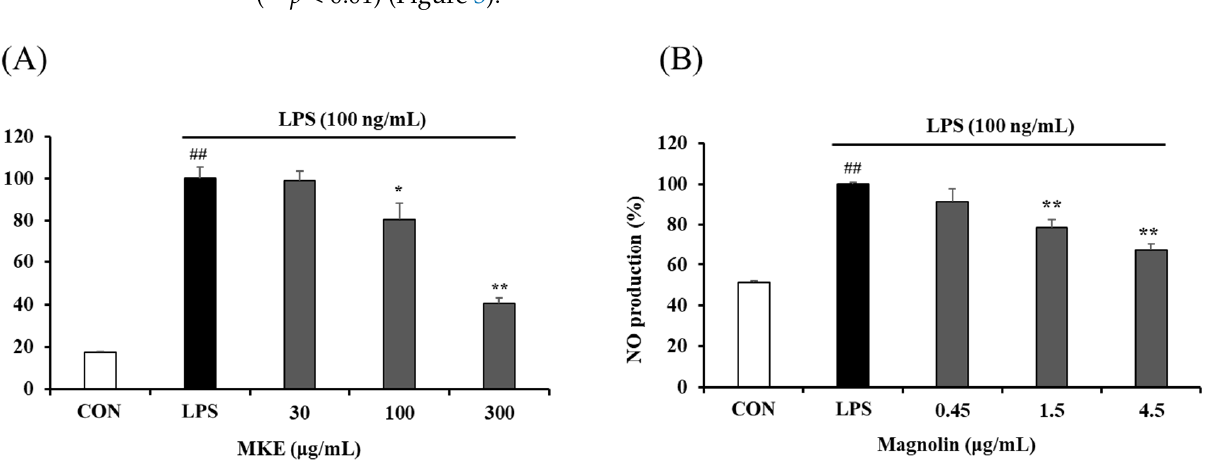
Figure 2. Effect of ( A ) MKE (0, 30, 100, and 300 μg/mL) and ( B ) magnolin (0, 0.45, 1.5, and 4.5 μg/mL) on RAW 264.7 cell viability. MKE and magnolin were used for 24 h of treatment. Values are repre- sented as means ± standard deviation.